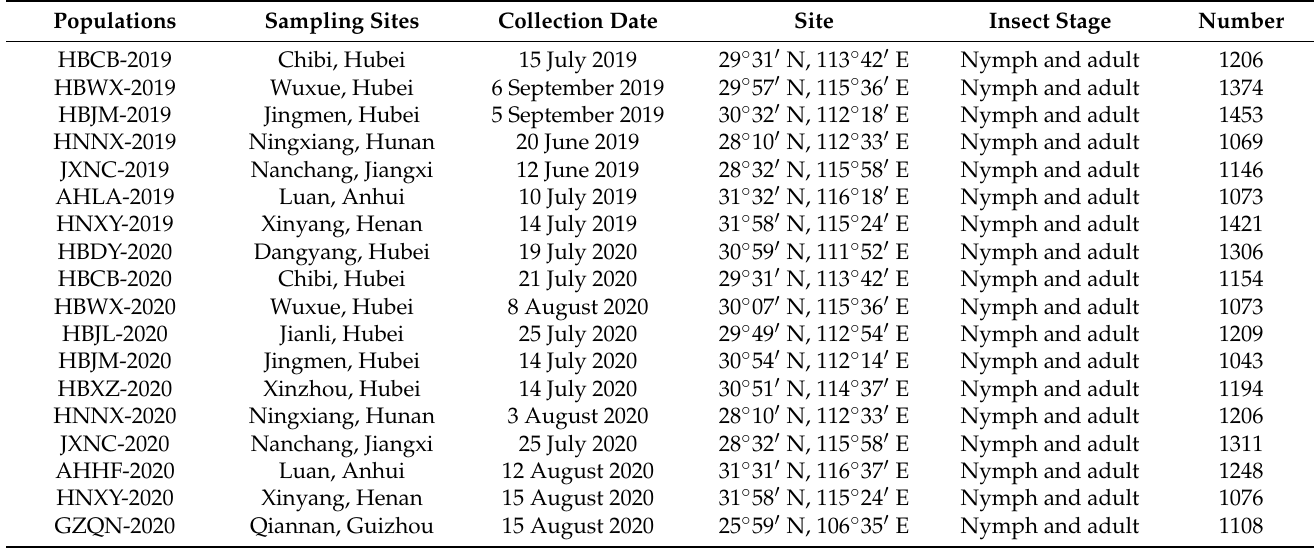
Table 1. Information of S. furcifera collected from rice paddy fields of